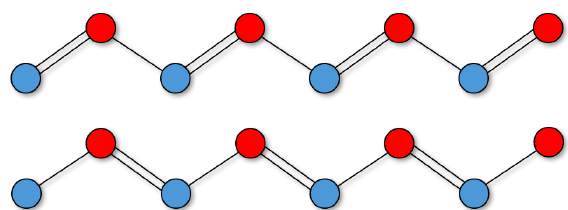
Figure 6: Two different patterns of dimerization in the SSH model representing (top) δ t > 0 and (bottom) δ t < 0. Sublattices A and B are represented by blue and red respectively. The unit cell of A and B together represent a well defined unit that has a well defined connection to the molecular limit. Double lines indicates a double covalent bond making the atoms are closer and hence the hopping